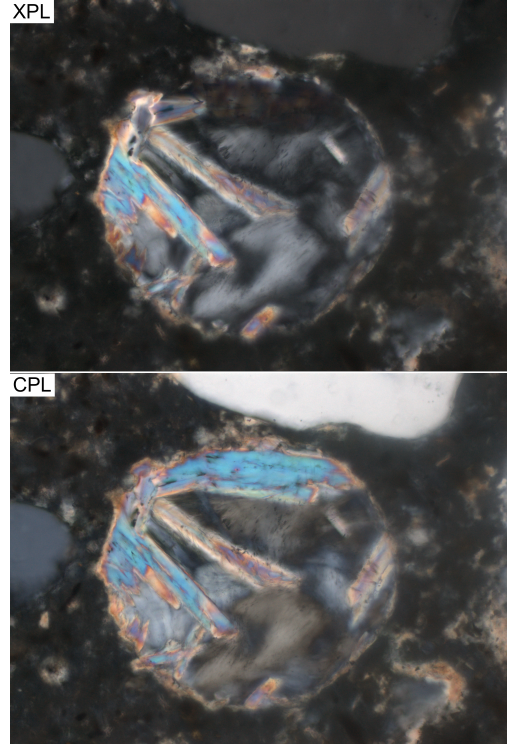
Figure 1. Photomicrographs of the same portlandite cluster in an air void under crossed polarization ( XPL ); and circular polarization ( CPL ) light modes. The field of view is 350 µ